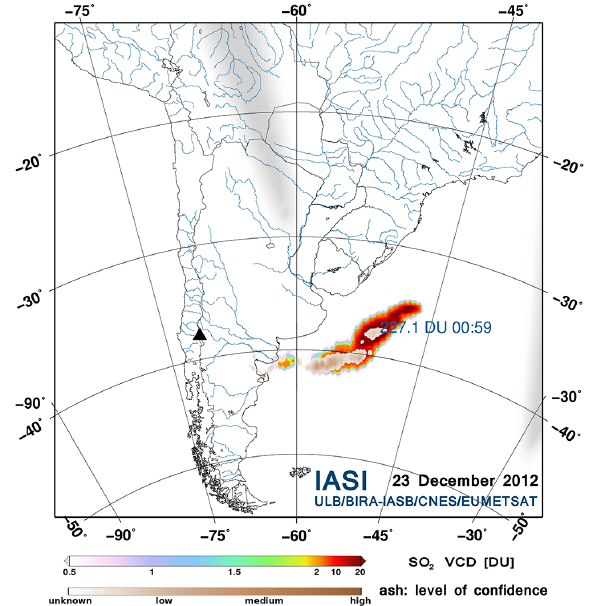
Fig. 26. Time series of the number of detections per day of ash (up- per panel) and SO 2 (lower panel) by IASI-A for the period 2007–